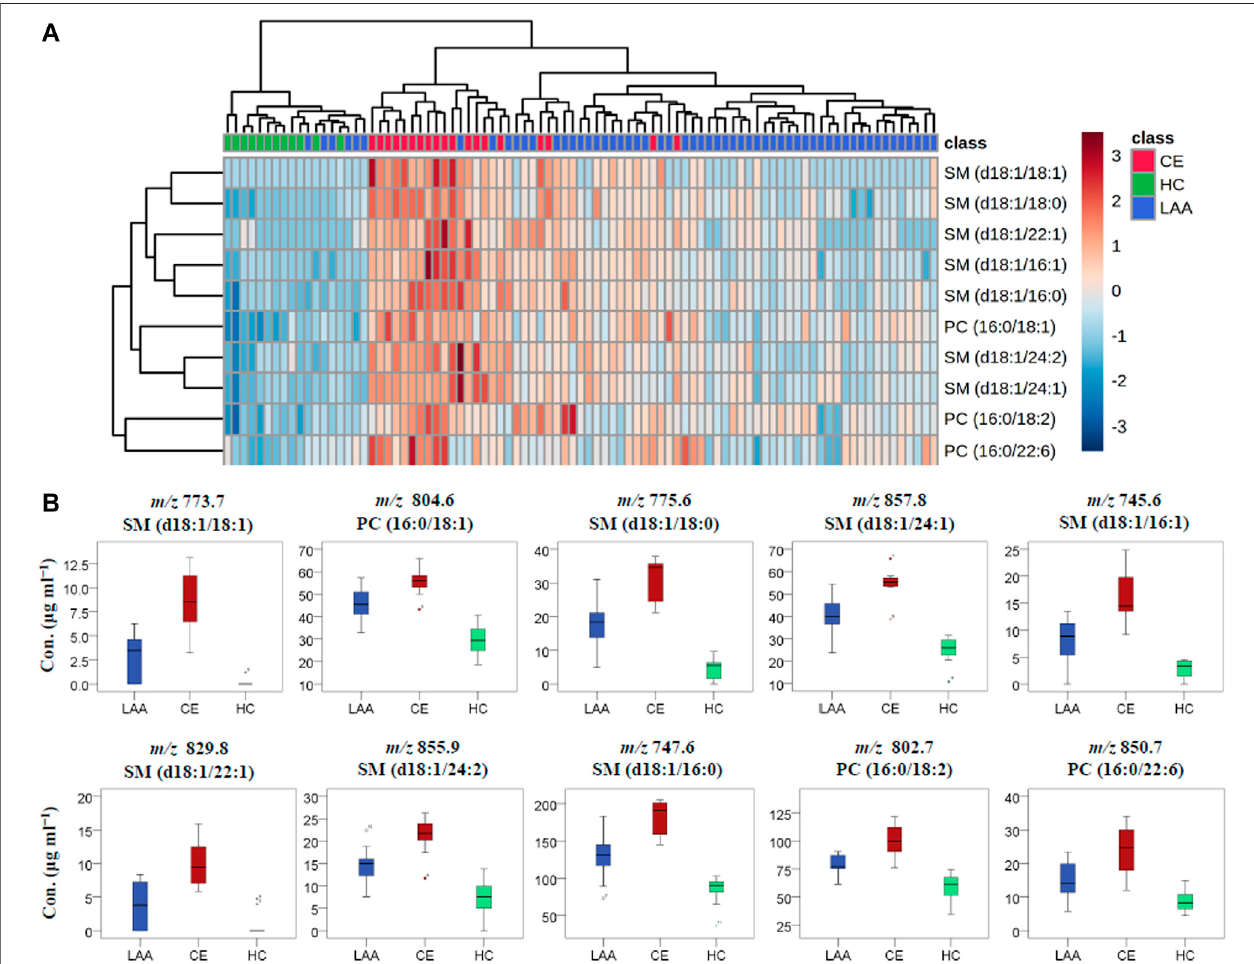
FIGURE 3 | The visualized heatmap (A) and boxplots (B) of the determined concentration results of ten identi fi ed PL biomarkers in LAA, CE, and HC